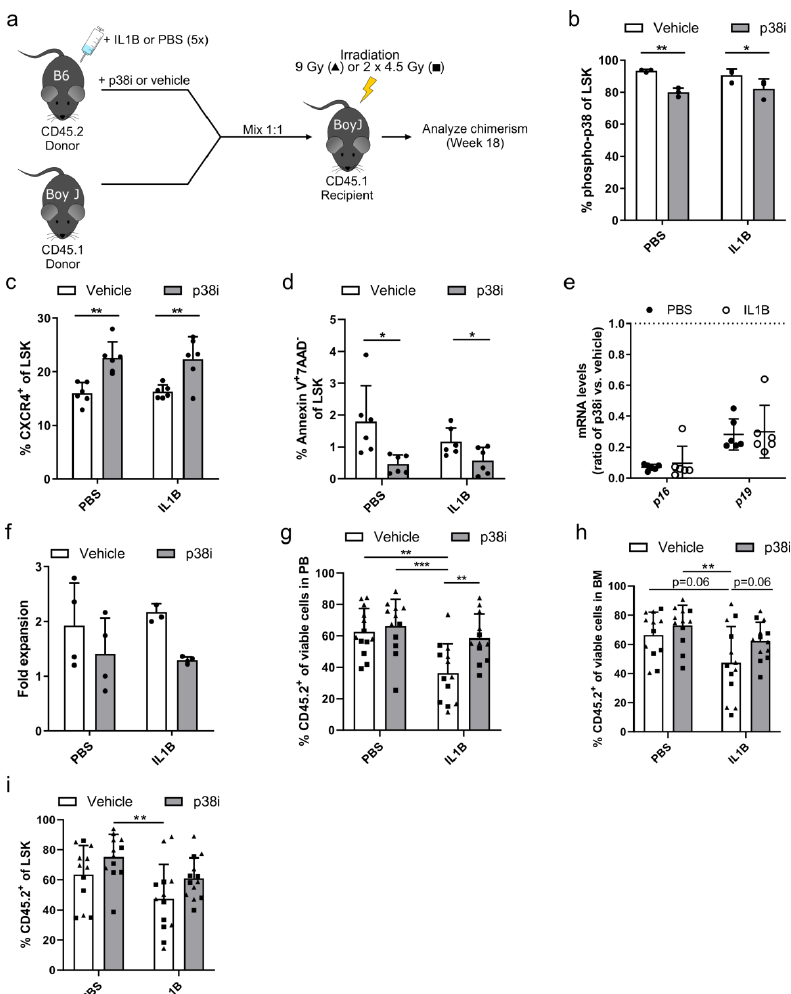
Figure 4. Inhibition of p38 MAPK improves the engraftment of IL1B-challenged HSPCs. ( a ) Schemata of competitive bone marrow transplantation after IL1B challenge. HSPCs derived from IL1B-challenged or PBS-control CD45.2 + donor mice were cultured for 2.5 days in the presence of a p38 small molecule inhibitor (p38i) or DMSO as vehicle control. Untreated CD45.1 + HSPCs were used as competitors. Donor cells were mixed in a 1:1 ratio and transplanted into irradiated CD45.1 + recipient mice. Recipients were irradiated either with a single dose of 9 Gy (triangles) or a fractionated dose of 2 × 4.5 Gy (squares). The animals were analyzed on week 18 after transplantation. ( b ) Intracellular staining was performed to detect phospho-p38 levels in IL1B-challenged or PBS-control LSK cells after cultivation of HSPCs with p38i or vehicle control. ( c ) Prior to transplantation, expression of the HSC homing factor CXCR4 was analyzed in LSK cells derived from IL1B-challenged or PBS-control donor mice after cultivation with p38i or DMSO as vehicle control. ( d ) Apoptotic cells were assessed in LSK cells treated with p38i or DMSO as vehicle control by staining for Annexin V + and 7AAD - cells. ( e ) Quantitative RT-PCR was performed to detect p16 and p19 mRNA levels in HSPCs treated with p38i in relation to vehicle-treated HSPCs. Expression levels were normalized to β -Actin levels. The dotted line at 1.0 indicates the level of normalization (no up- or downregulation). ( f ) The cell expansion during cultivation of IL1B-challenged or PBS-control HSPCs was quantified by comparing the cell count before and after treatment with p38i or DMSO as vehicle control. ( g ) The frequency of CD45.2 + donor cells was analyzed in the peripheral blood of animals 18 weeks after transplantation of p38i-treated or vehicle control HSPCs. ( h ) The CD45.2 + donor cell engraftment was measured in bone marrow samples of transplanted animals 18 weeks after transplantation of p38i-treated or vehicle control HSPCs. ( i ) The frequency of CD45.2 + donor cells was assessed in LSK cells on week 18 after transplantation in the bone marrow of mice transplanted with p38i-treated or DMSO-treated vehicle control HSPCs. Statistics: in vitro experiments ( b – f ): n = 3–6, mean ± SD, two-way ANOVA comparing row means only ( b,c,f ) or multiple t -test correcting for multiple comparisons using the Holm–Sidak method ( d ), in vivo experiments ( g – i ): n = 13, four independent experiments, mean ± SD, two-way ANOVA, * p < 0.05, ** p < 0.01, *** p <